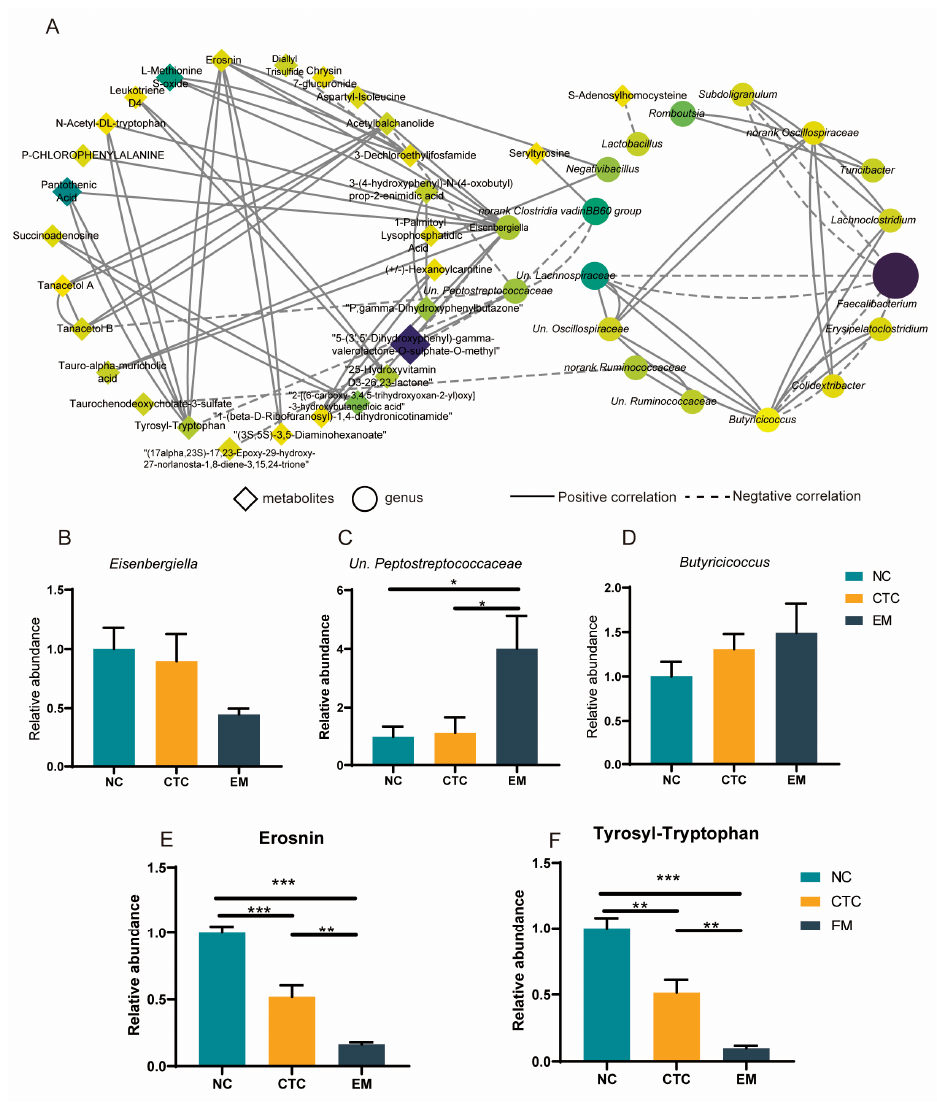
Figure 8. ( A ) Network analysis of the 30 most abundant cecal microbial genera with differential serum metabolites in the NC, CTC, and EM groups. Relative abundance of core genera Eisenbergiella ( B ), Un. Peptostreptococcaceae ( C ) and Butyricoccus ( D ). Relative abundance of the core serum metabolites Erosnin ( E ) and tyrosyl − tryptophan ( F ) among the treatment groups. Diamonds represent the differential serum metabolites and the circles represent the 30 most abundant cecal microbial genera.